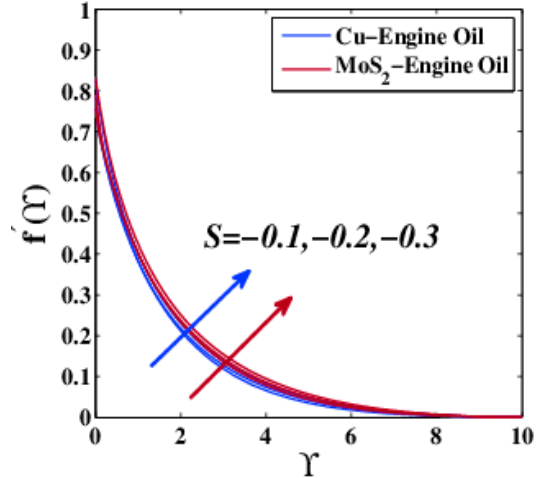
Figure 27. Velocity variation f (cid:48) ( Y ) under the influence of S < 0.